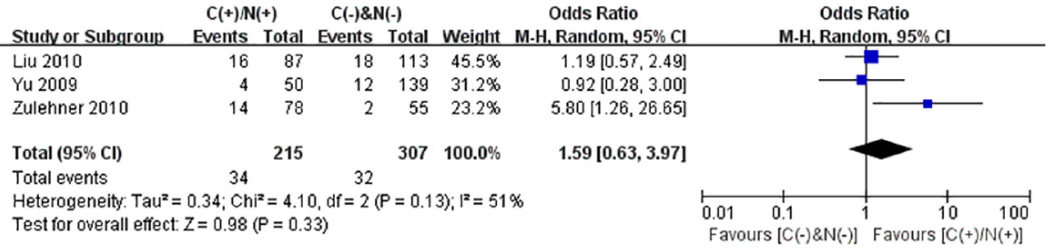
Figure 8. Forest plot of odds ratio for the association of b -catenin expression in cytoplasm and/or nucleus with liver cirrhosis.